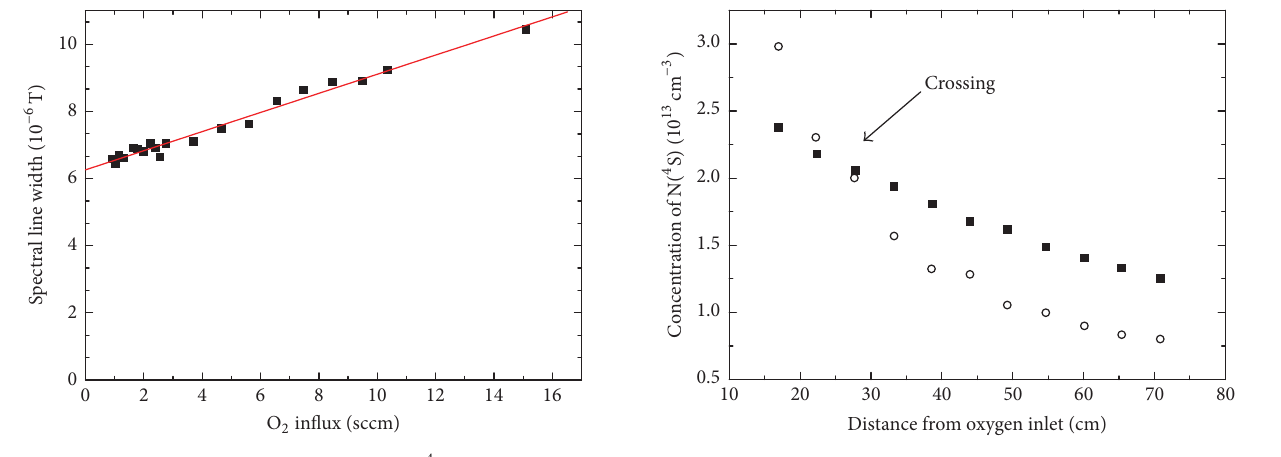
Figure 3: Linewidth of N atom ground state ( 4 S 3/2 ) EPR line as a function of oxygen admixture.